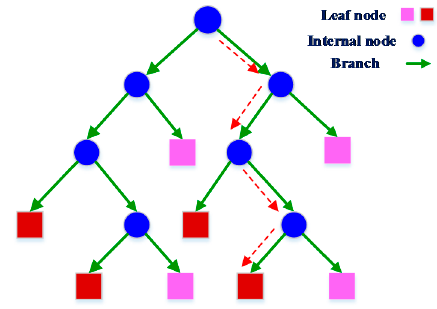
Figure 8. Decision tree graphical model.